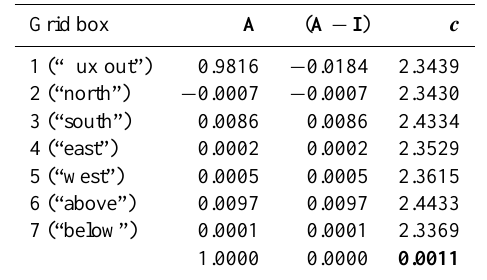
Table 1. Example of using a transport matrix to calculate PO 4 rem- ineralisation (µmolkg − 1 yr − 1 ) in one grid box from PO 4 concen- trations (µmolkg − 1 ) given in c . Grid boxes, taken from a row of the TM, are arbitrarily numbered, where 1 is the central grid box where the calculation is taking place. The example shows a simplified situ- ation where there are six neighbouring grid boxes with their relation to the central grid box given by the directions in brackets. Each co- efficient in the six boxes represents the flux of PO 4 into the central box from that grid box. The coefficient in the central grid box for A (see Eq. 1) represents the amount of tracer left in the central grid box after one time step, whilst the coefficient for A − I (see Eq. 2) is the flux out, equal to 0.9816–1. The sum of coefficients is shown underneath, with the estimated remineralisation ( q in Eq. 2) in bold calculated as the sum of the element-wise multiplications of A − I and c